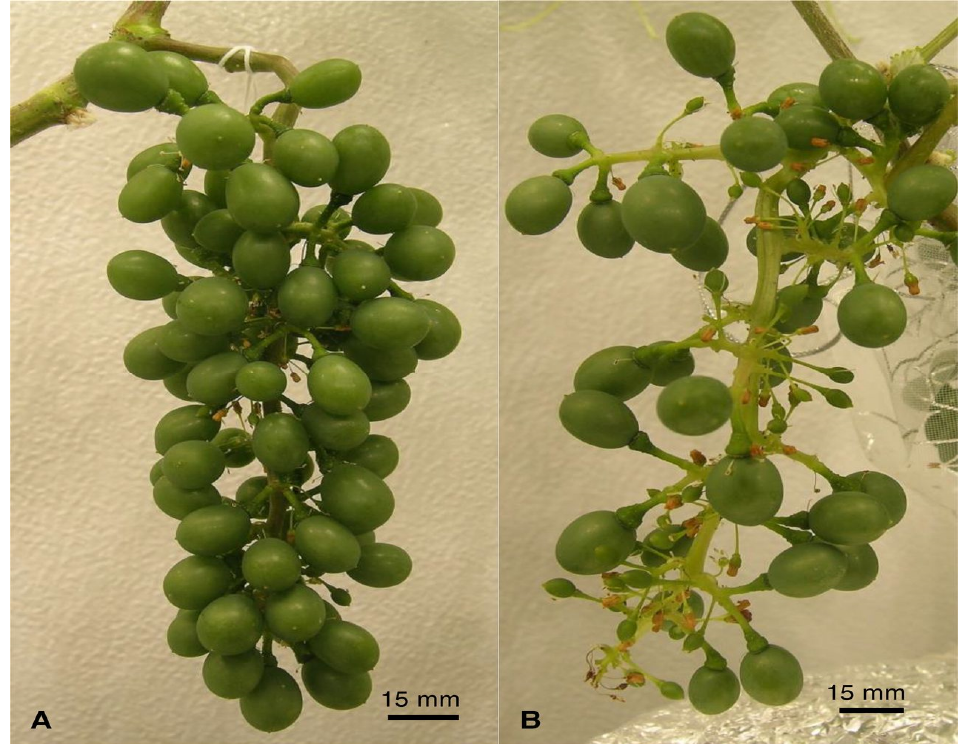
Figure 3. Bunches, grapevine cultivar Shiraz. Control bunch ( A ); Salt-stressed bunch ( B ); showing symptoms of coulure and millerandage. Salt treatment was applied from budburst until veraison via fertigation with 35 mM NaCl added to control nutrient solution [136].